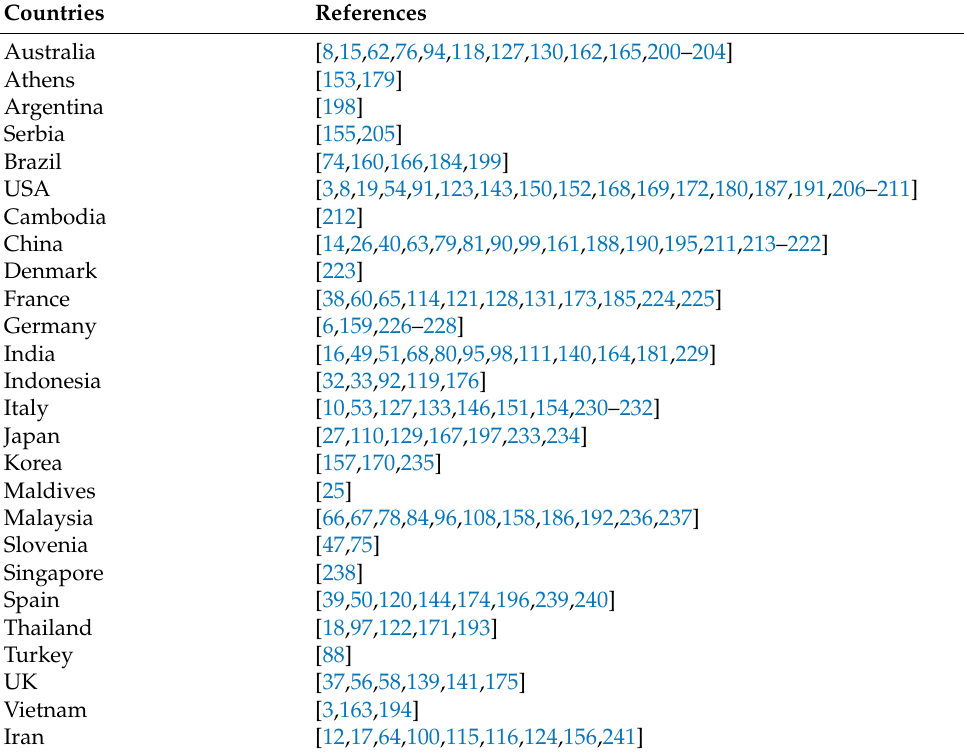
Table 5. Countries, with